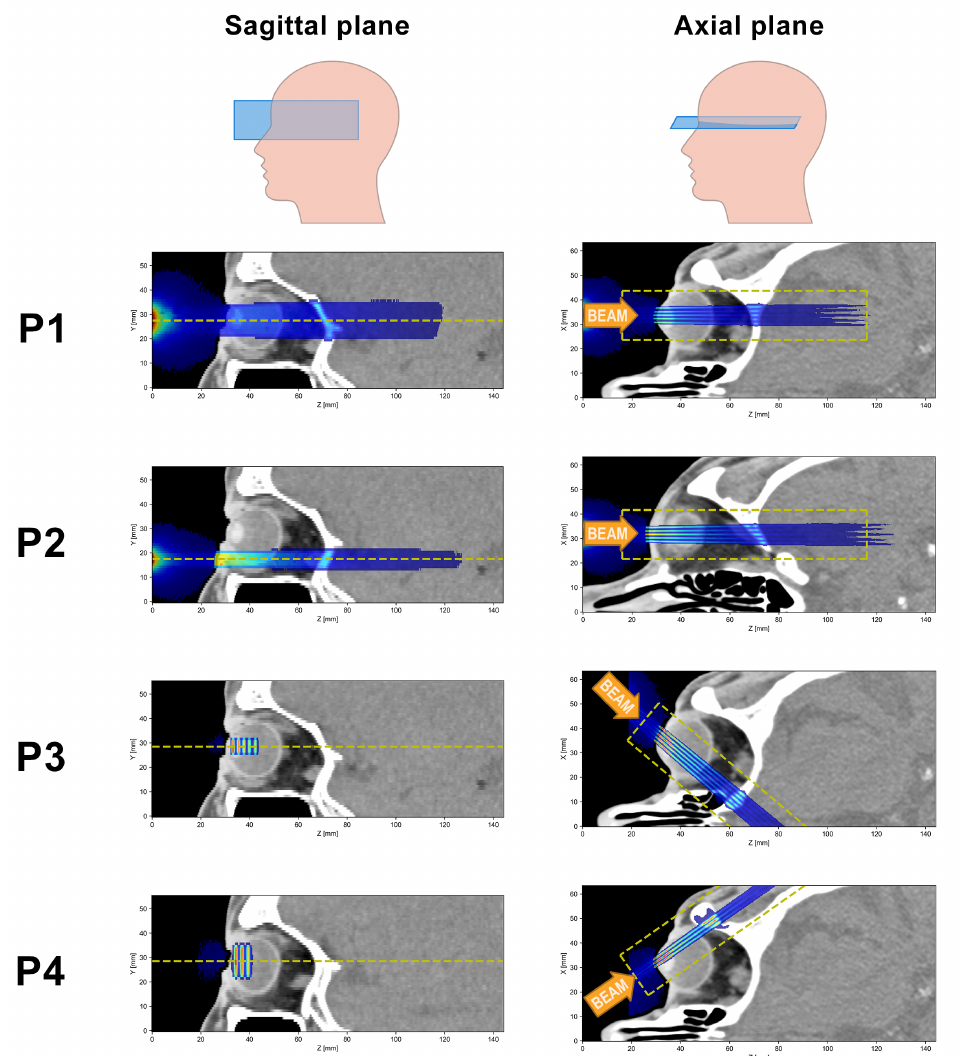
Figure 2. Illustration of the four different irradiation positions (P1–P4): For each row, the left and right panels show sagittal and axial sections, respectively, of the same dose distribution, while the orange arrows indicate the beam direction. The dashed yellow lines in the left panels indicate the position of the dose slices mentioned in Section 2.2, while the dashed yellow rectangles in the right panels outline the region within the slices that were considered in the dose